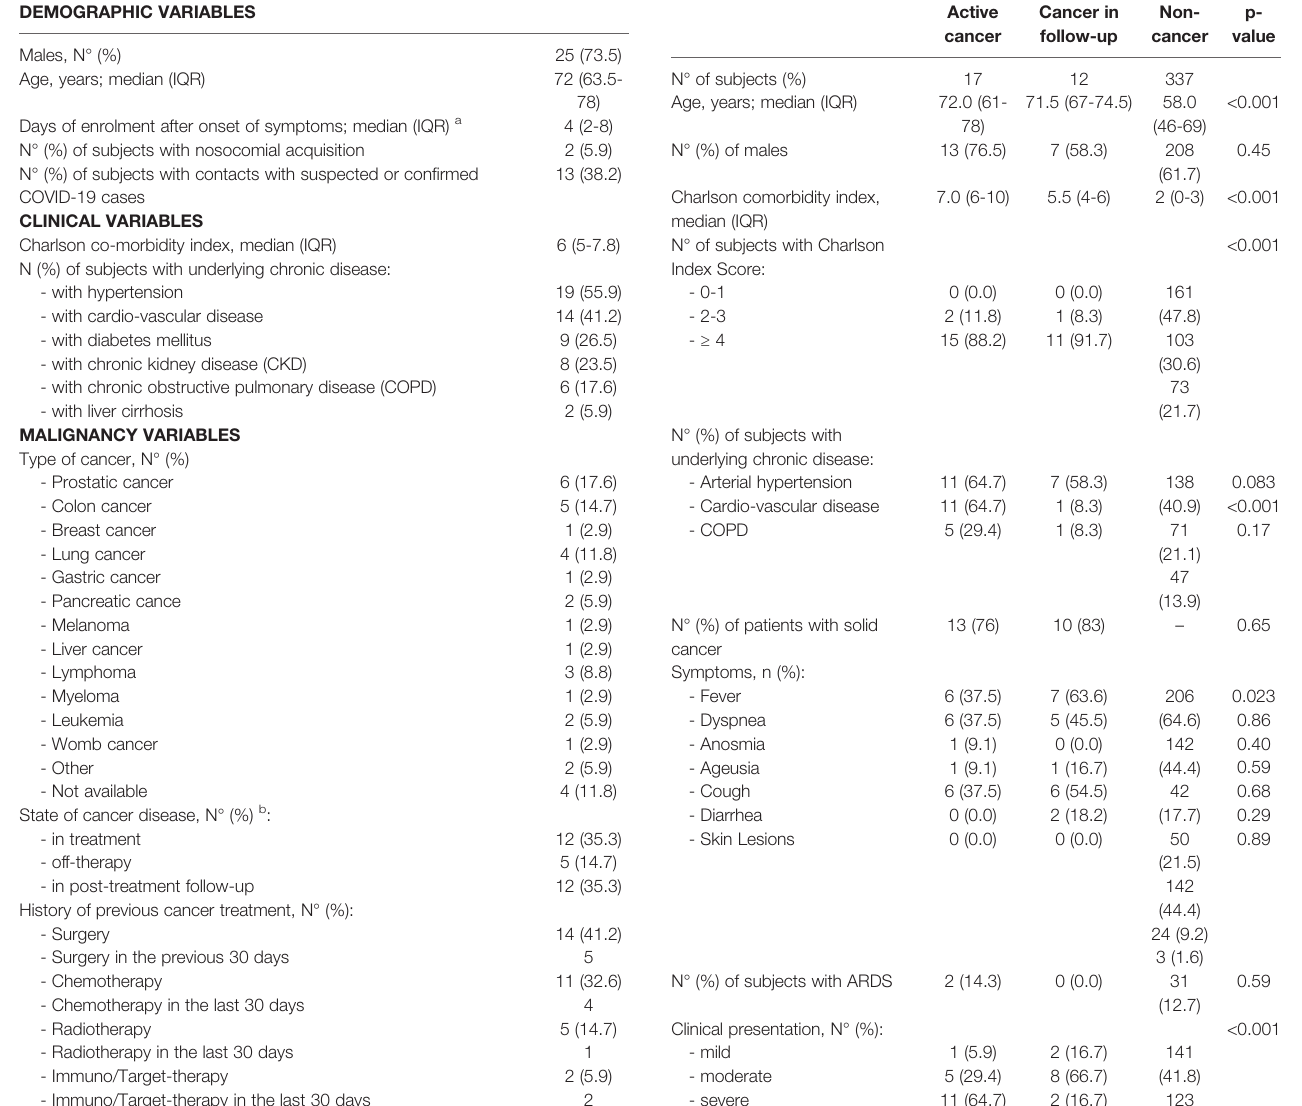
TABLE 2 | Comparison of patients with active cancer vs patients with cancer in the follow-up vs patients without cancer.